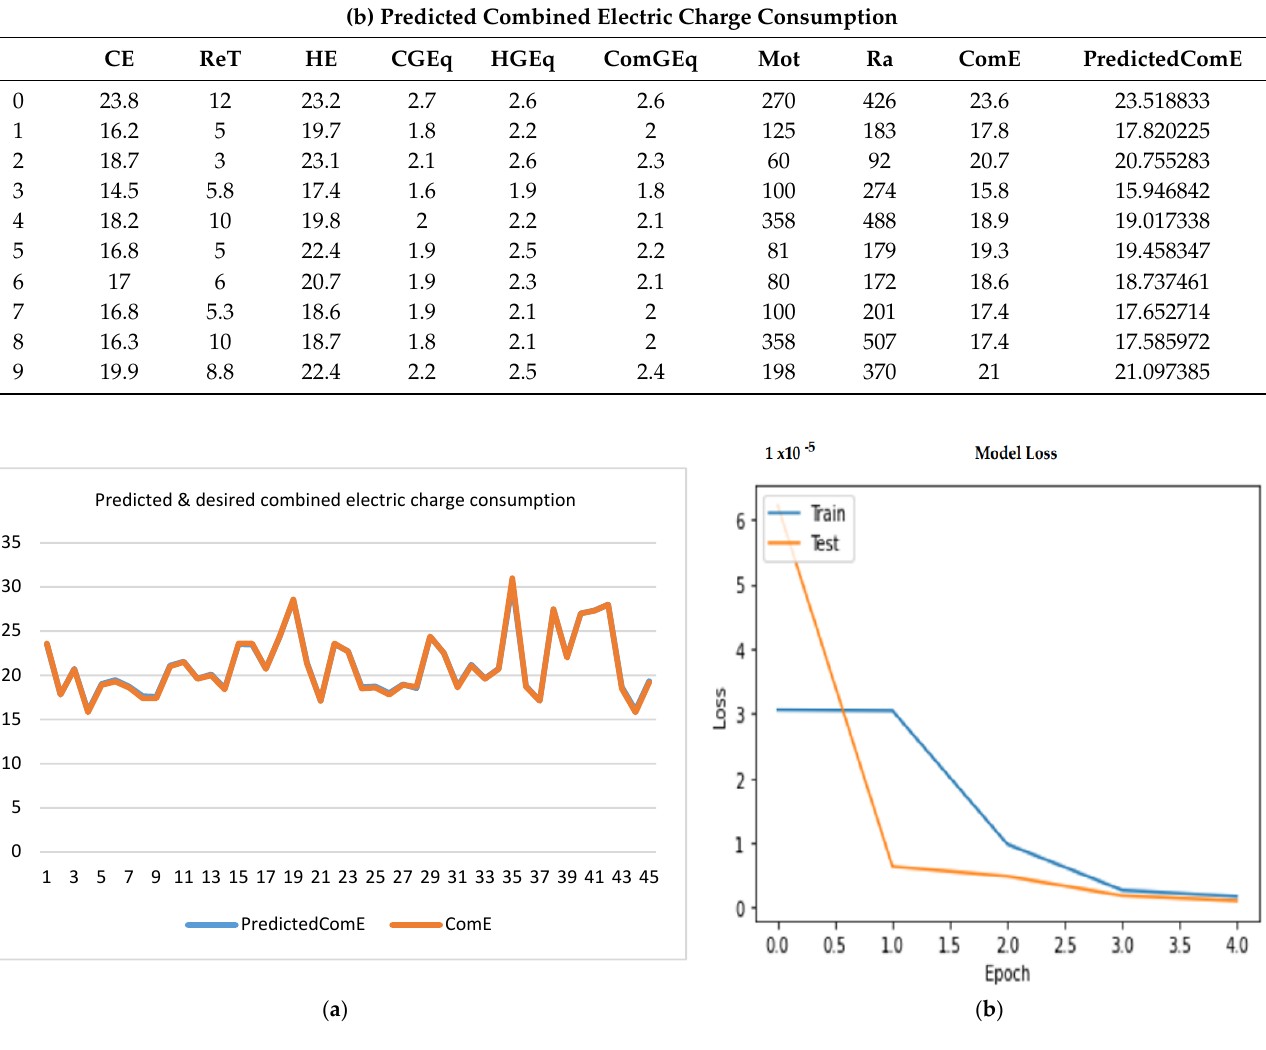
Figure 6. Performance measurement of the combined electric charge consumption. ( a ) Behaviour of the combined electric charge consumption; ( b ) Model loss with increase in epoch.